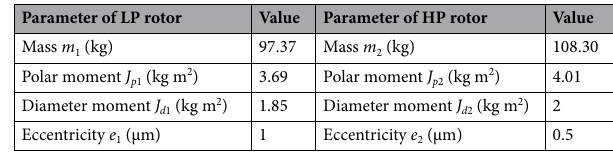
Table 1. Parameters of the dual-rotor system.